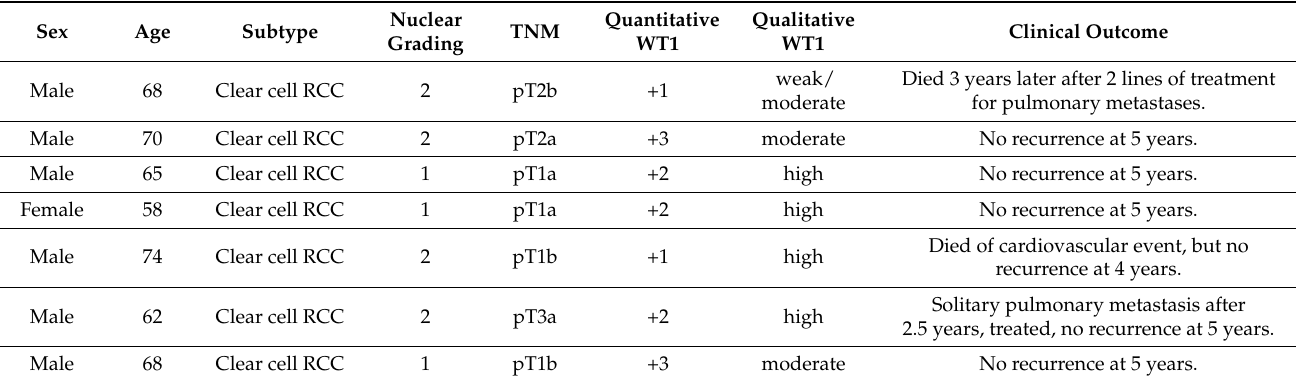
Table 3. Positive intratumoral WT1 staining